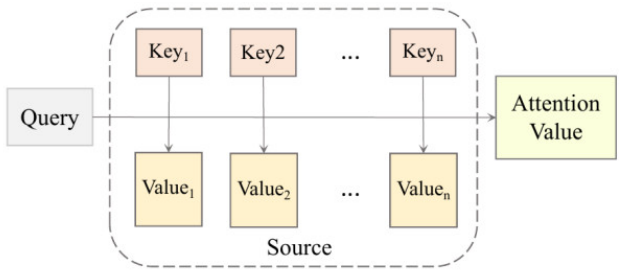
Figure 5. Attention Figure 5 . Attention mechanism.